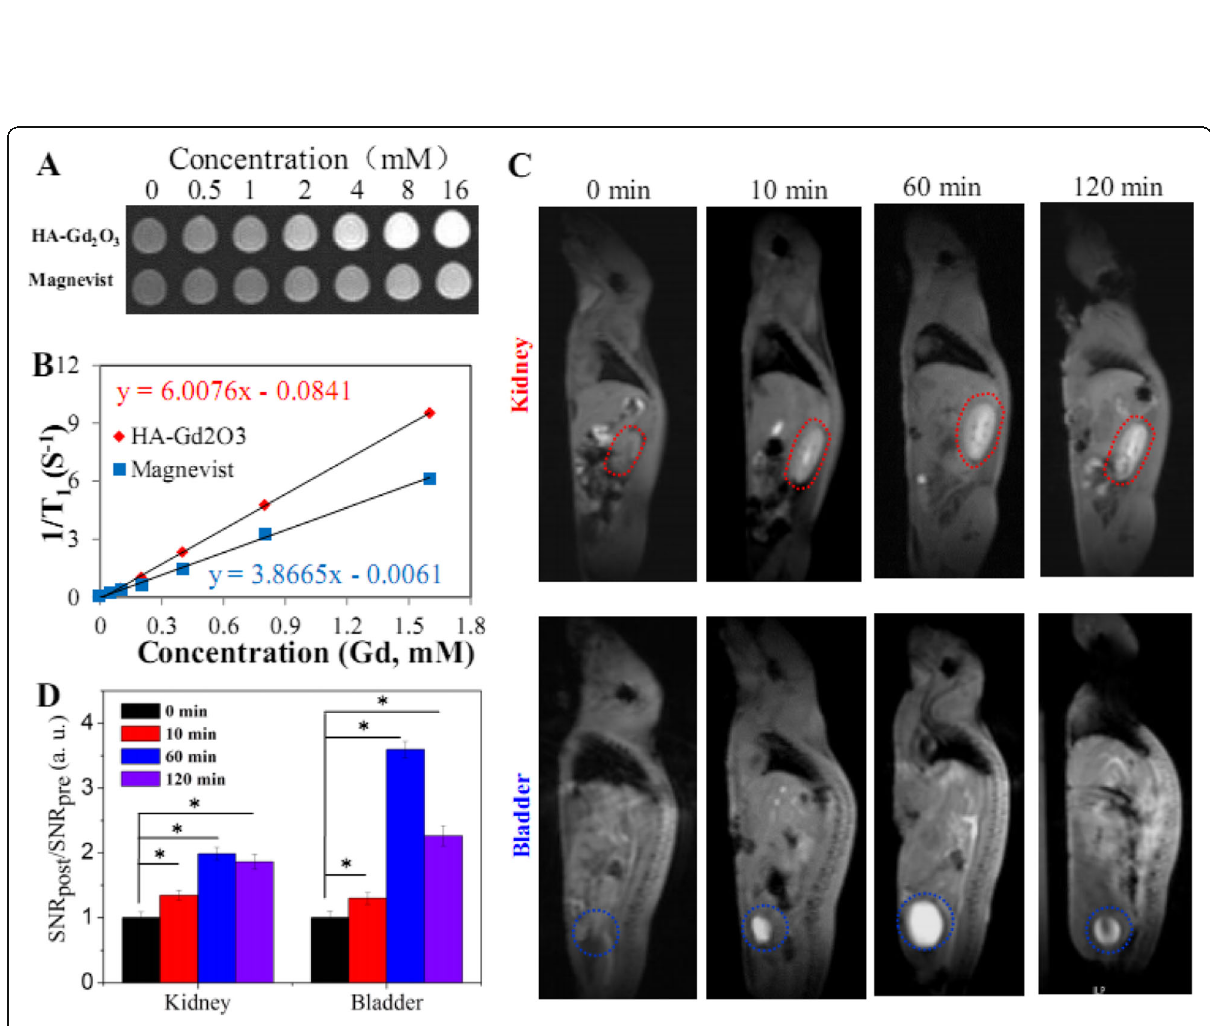
Fig. 4 a T 1 phantom images of the HA-Gd 2 O 3 NPs with different concentrations of total Gd ions. b The corresponding plots of 1/T 1 against concentrations of total Gd ions. c In vivo T 1 MR imaging and analysis of mice after intravenous injection of HA-Gd 2 O 3 NPs as contrast agents. d Quantification of signal changes (SNR ratio) in the bladder and kidney at different time points after administration ( n = 3). * p <